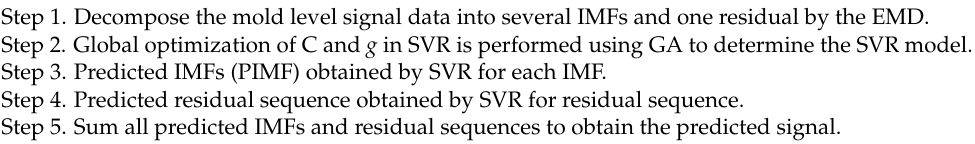
Table 1. The EMD-SVR GA algorithm.